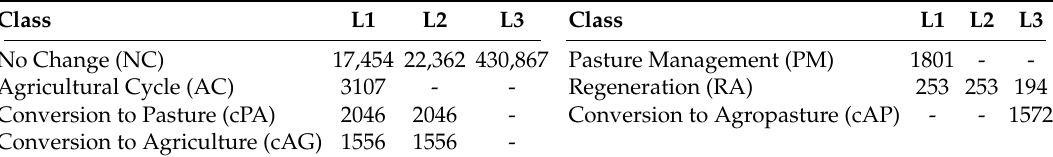
Figure 11. Labeled samples for collapsed change classes over band 5 of LANDSAT5/TM image acquired on 29 June